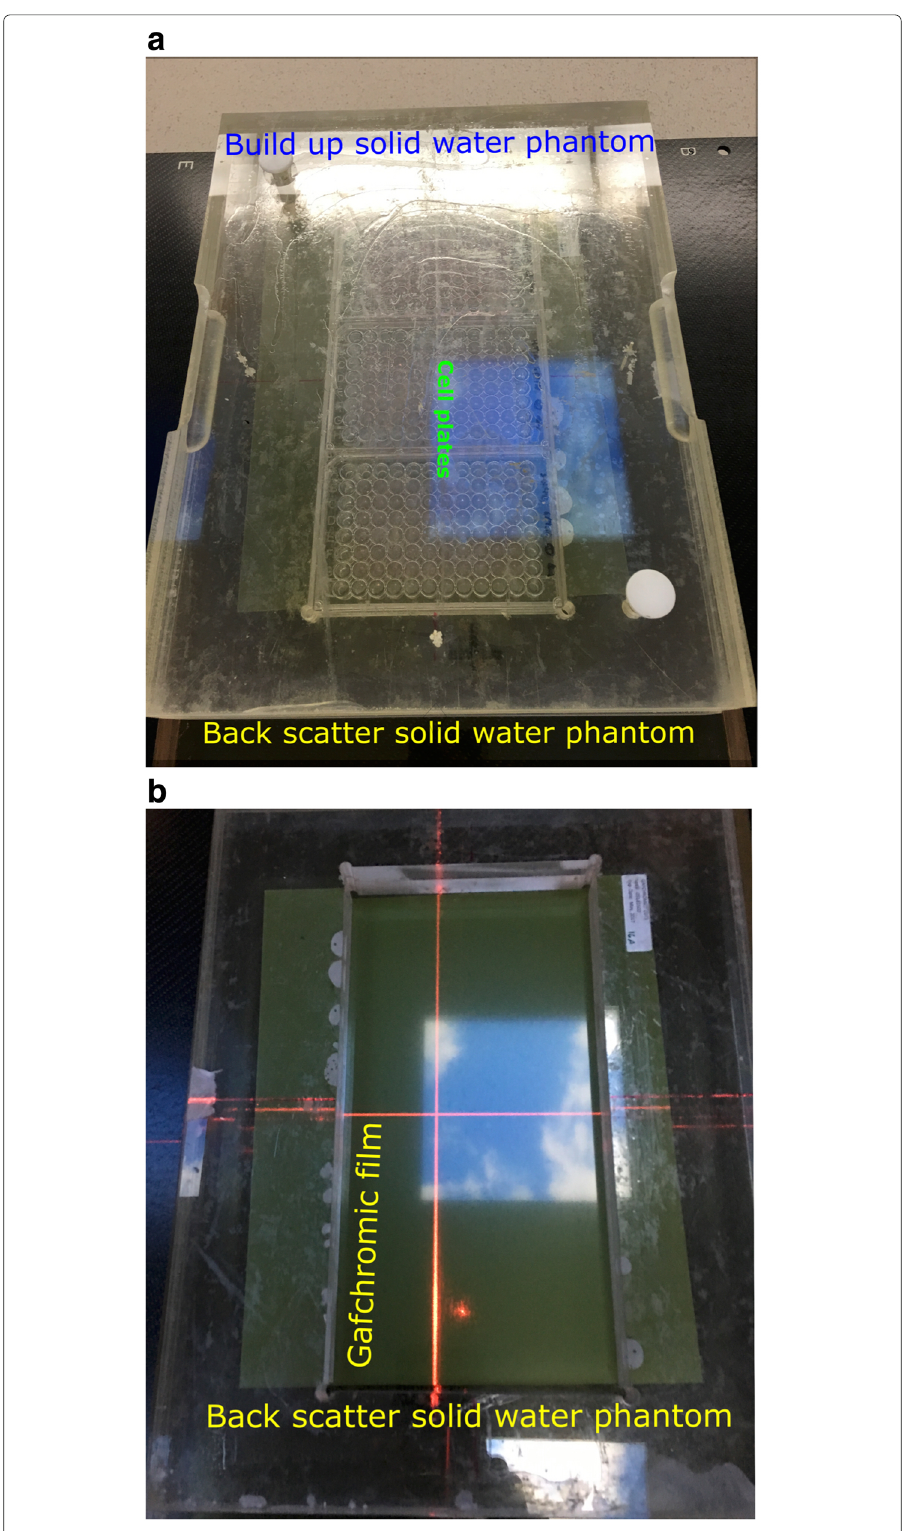
Fig. 1 Experimental set-up for irradiating the cells with a 6 MV linac photon beam: a cell plates between two solid water phantoms and b position of the Gafchromic